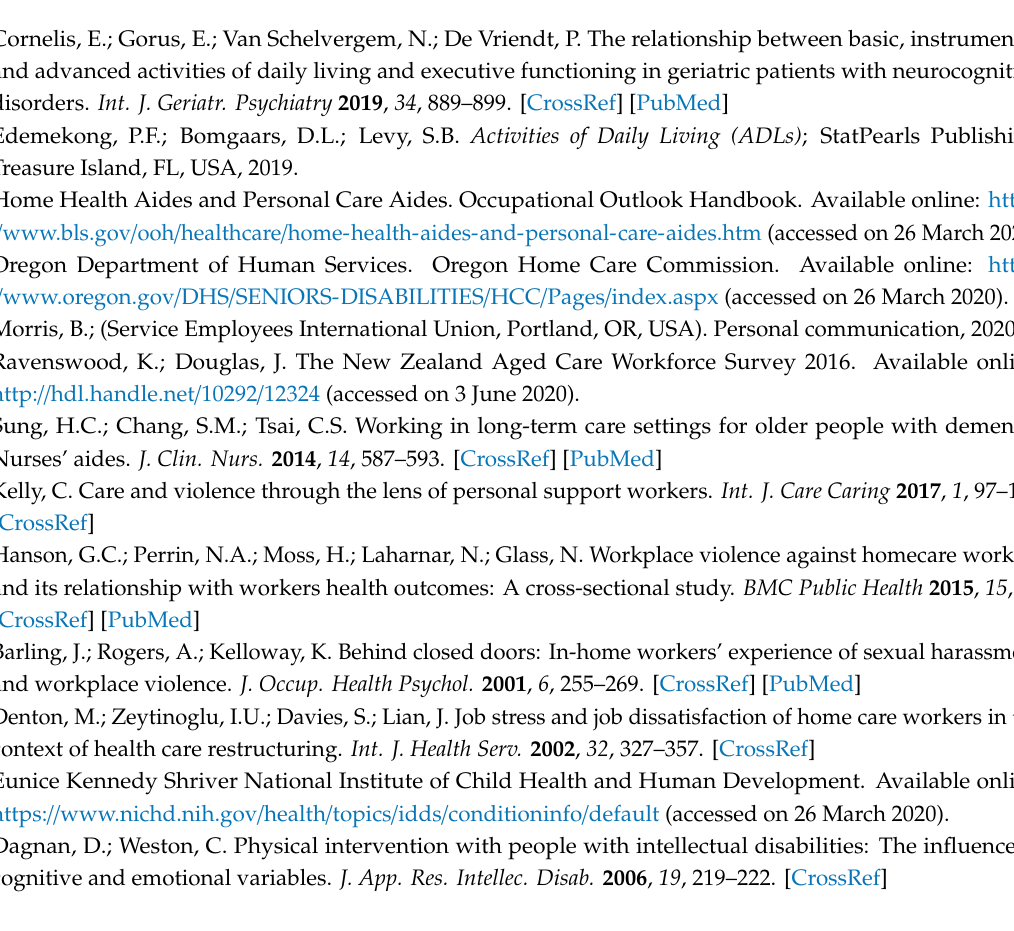
Table S2: Multivariable regressions predicting health outcomes of full-time PSWs from di ff erent forms of workplace